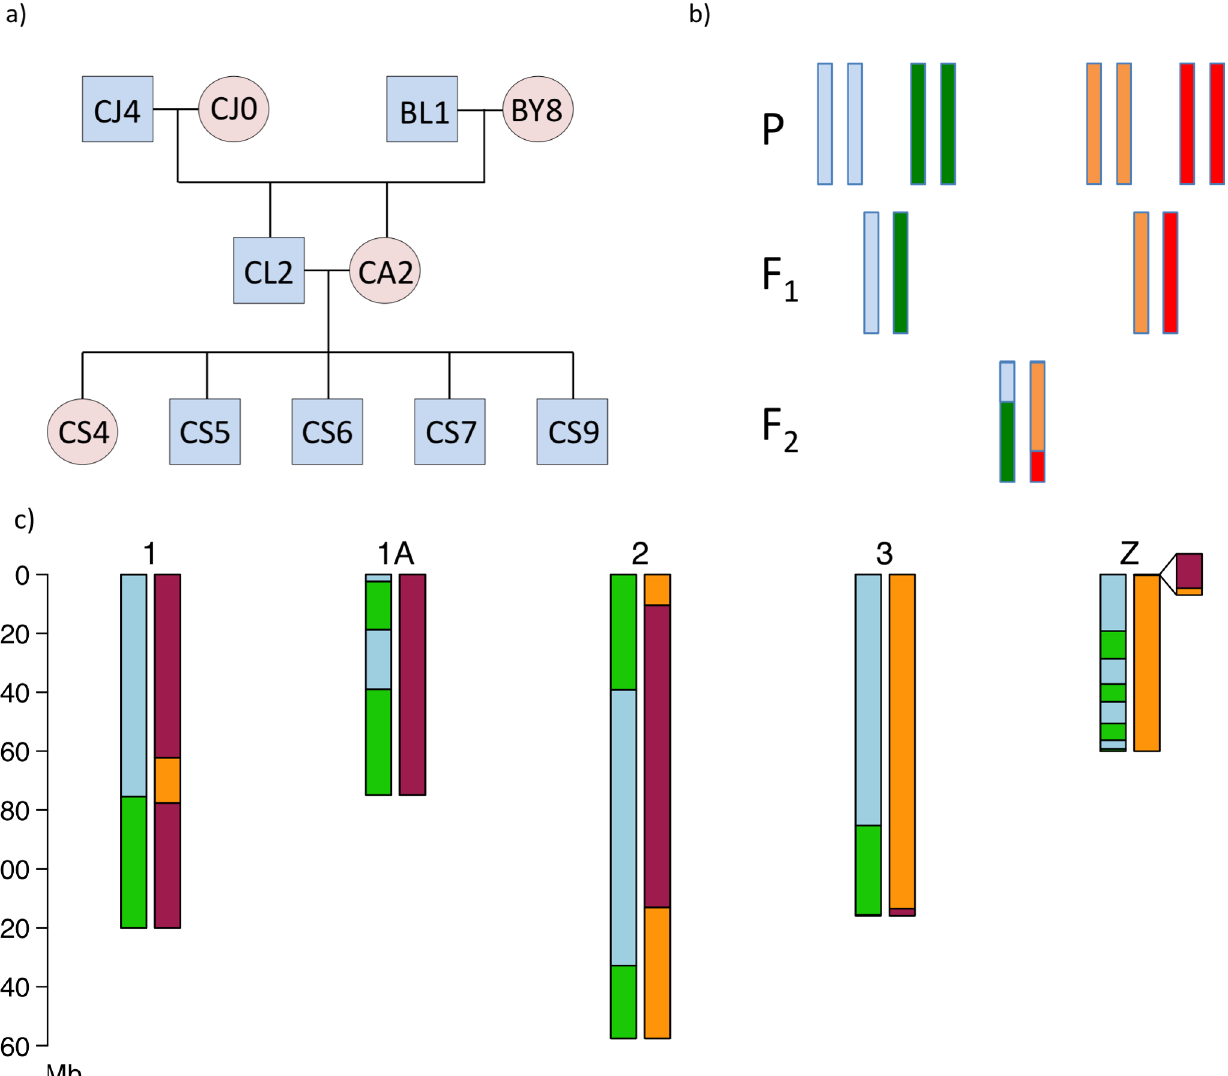
Fig 1. The flycatcher pedigree and illustration of crossover detection. ( a ) The three-generation pedigree used in this study. ( b ) Schematic illustration of phasing. A SNP can be phased when the grandparental genotypes differ from each other (either because they are homozygous for different alleles, or one is homozygous and the other is heterozygous) and the F 1 is heterozygous. If the phase can be traced also in the F 2 generation, it is possible to pinpoint recombination events in the F 1 gametes. ( c ) Haploblocks identified in the five largest chromosomes in one male F 2 offspring. The left chromosome in each pair represents the paternally transmitted chromosome and the right the maternally transmitted chromosome. Light blue is the contribution from the paternal grandfather, green the paternal grandmother, orange the maternal grandfather, and red the maternal grandmother. Note that the Z chromosome does not recombine in female meiosis, with the exception of in the pseudoautosomal region (PAR, insert).